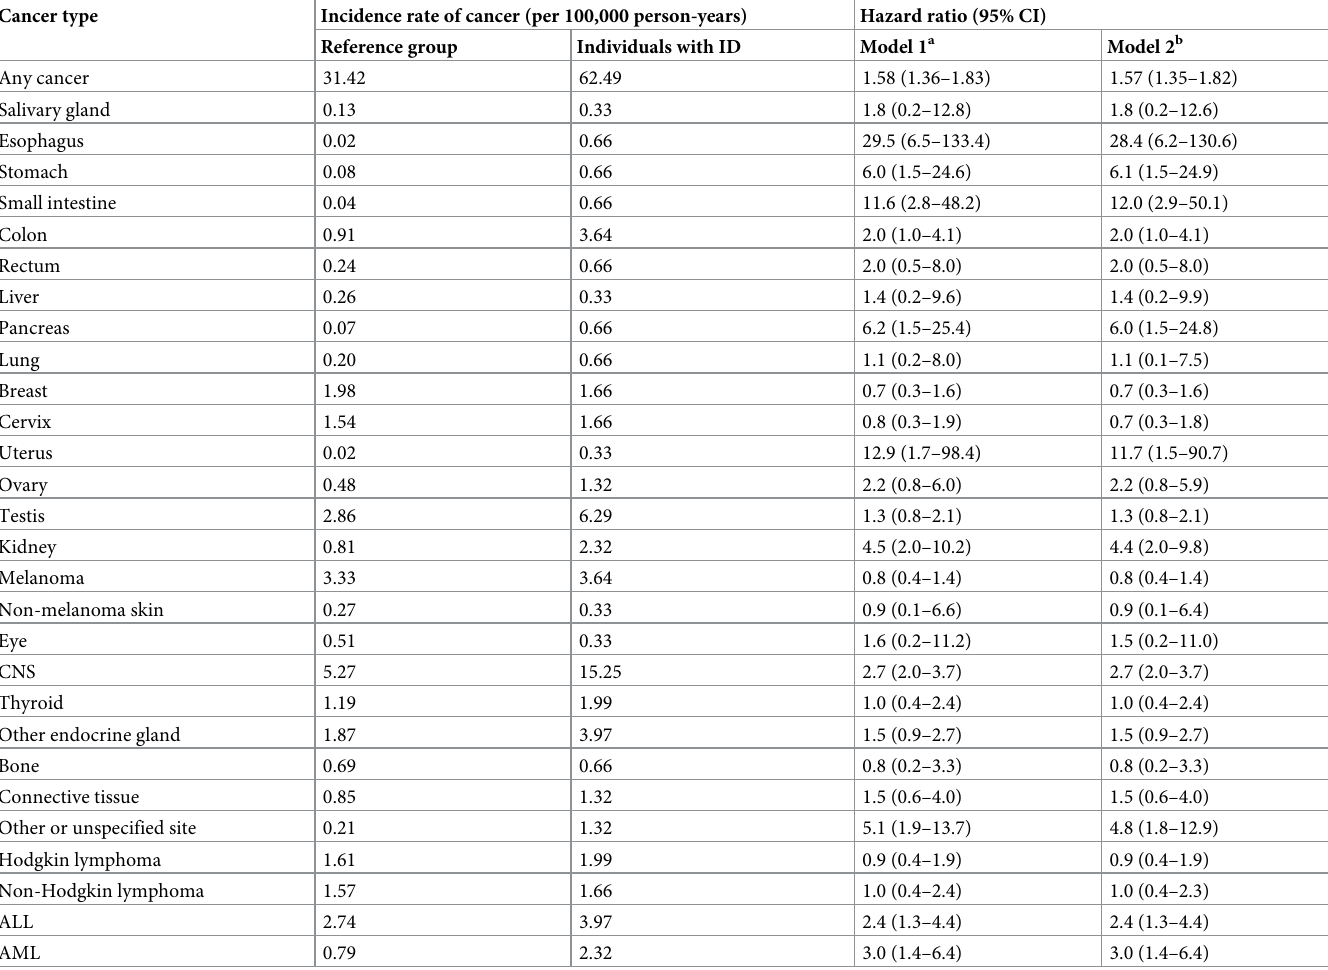
Table 2. Incidence rates and hazard ratios of cancer among individuals with ID by cancer type, compared to the reference